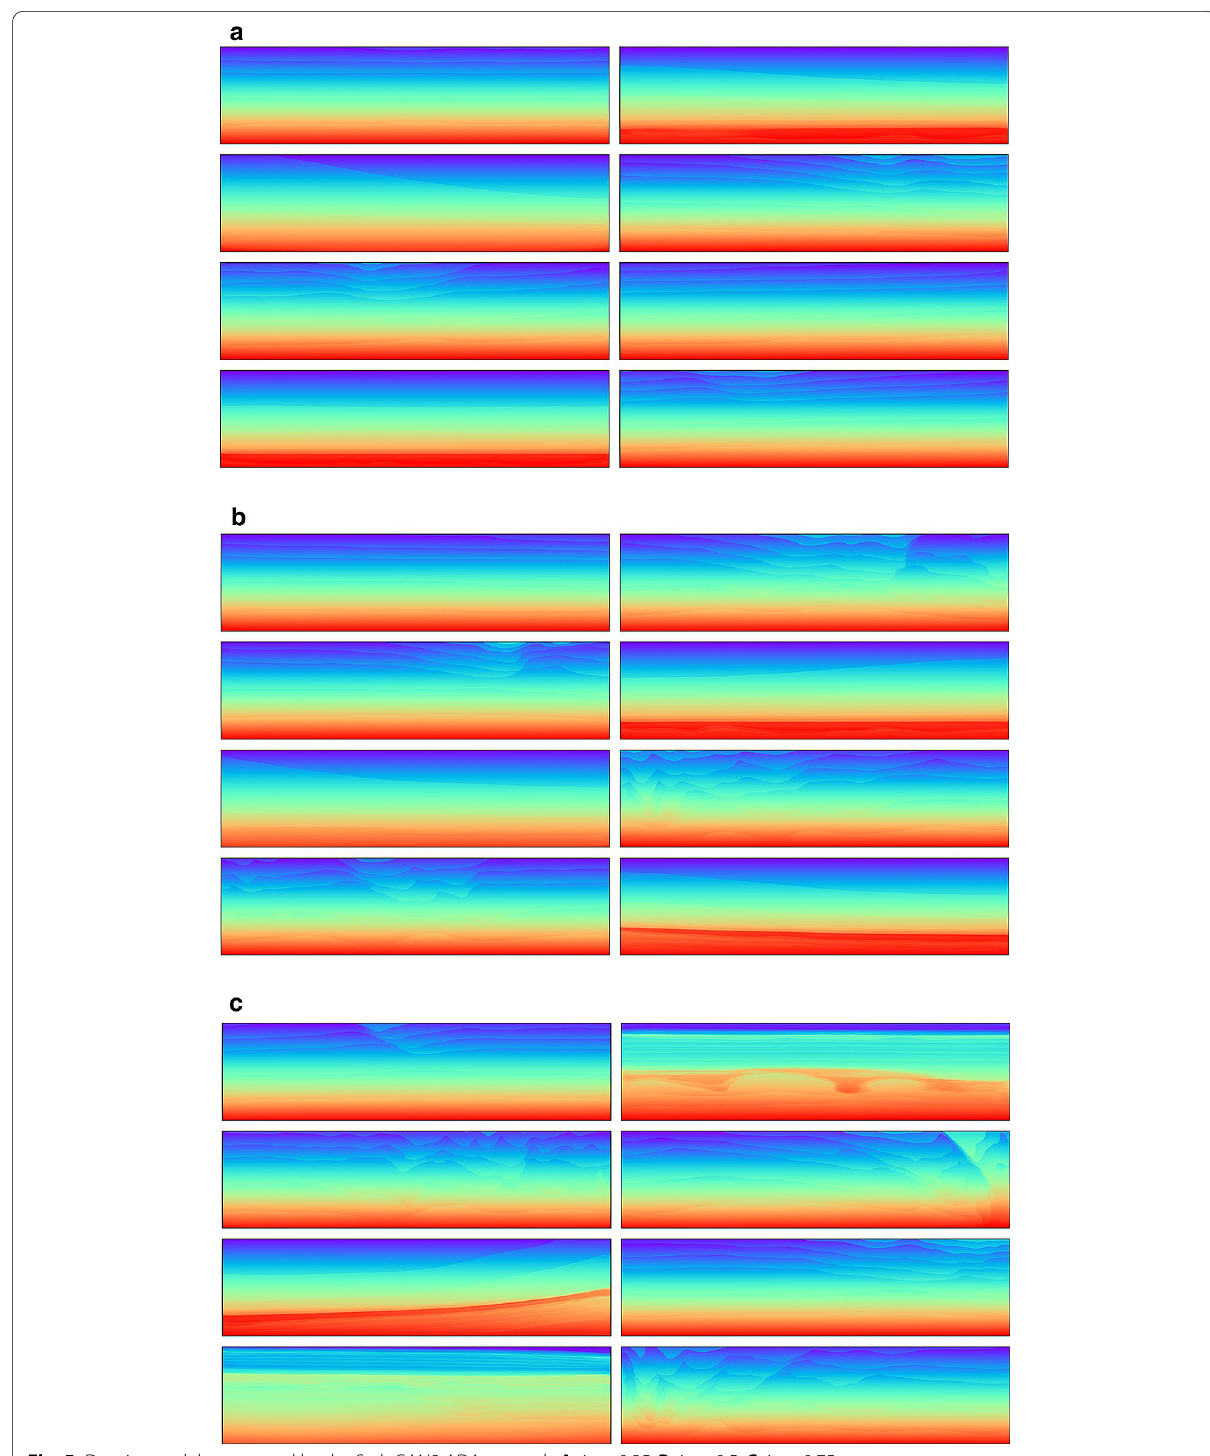
Fig. 5 Density models generated by the StyleGAN2 ADA network. A ψ = 0.25 . B ψ = 0.5 . C ψ =